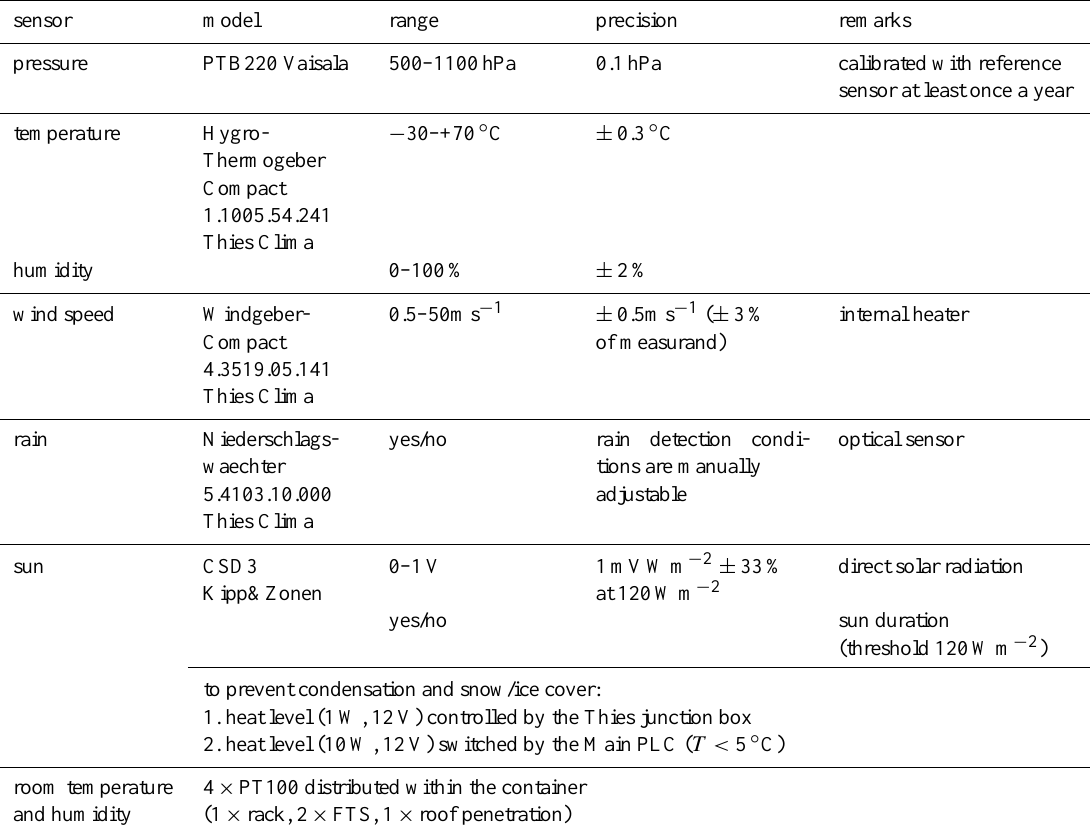
Table A2. The weather station